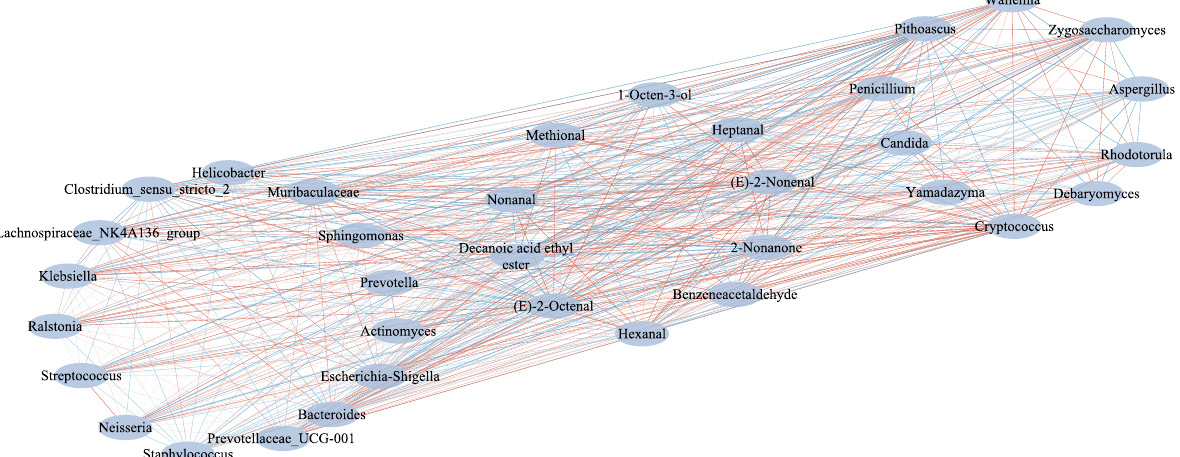
Figure 6. Correlation network of dominant microbial genera and key flavor substances of Mianning ham. The dominant bacterial genus and the dominant fungal genus are on the left and right, respectively. Additionally, the main flavor substance of Mianning ham is in the middle. The red line indicates a positive correlation between the two components and the blue line indicates a negative correlation between the two